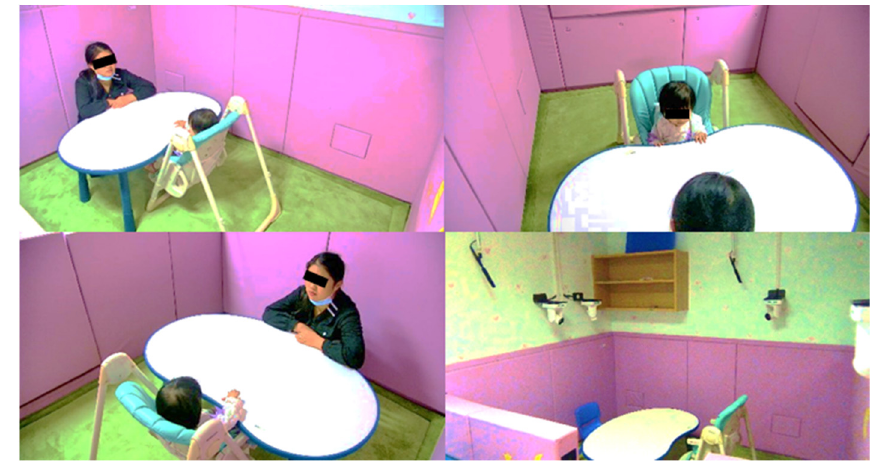
Figure 1. The still-face paradigm (SFP) behavioral video collection settings.